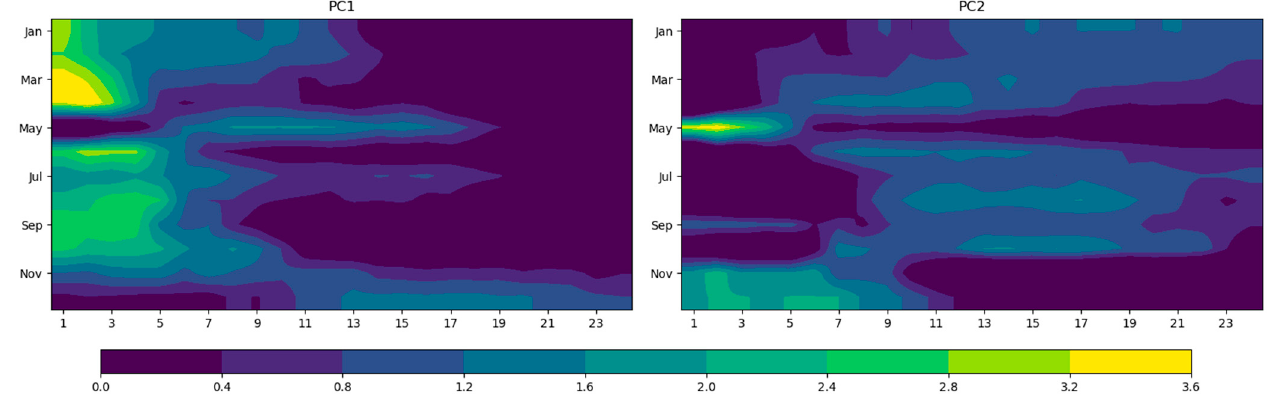
Figure 11. Scores of the two principal components obtained in the monthly series analysis for each accumulation period (1–24).